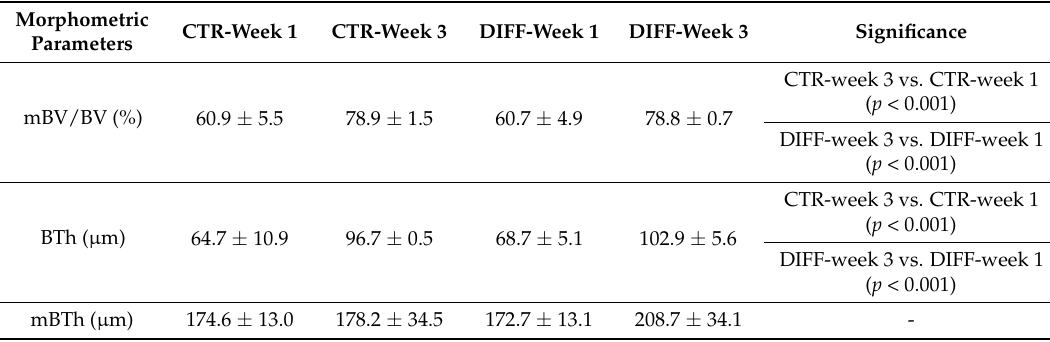
Table 1. Quantitative analysis of 3D data after the in vitro tests. The whole trabecular portion of the samples was considered.